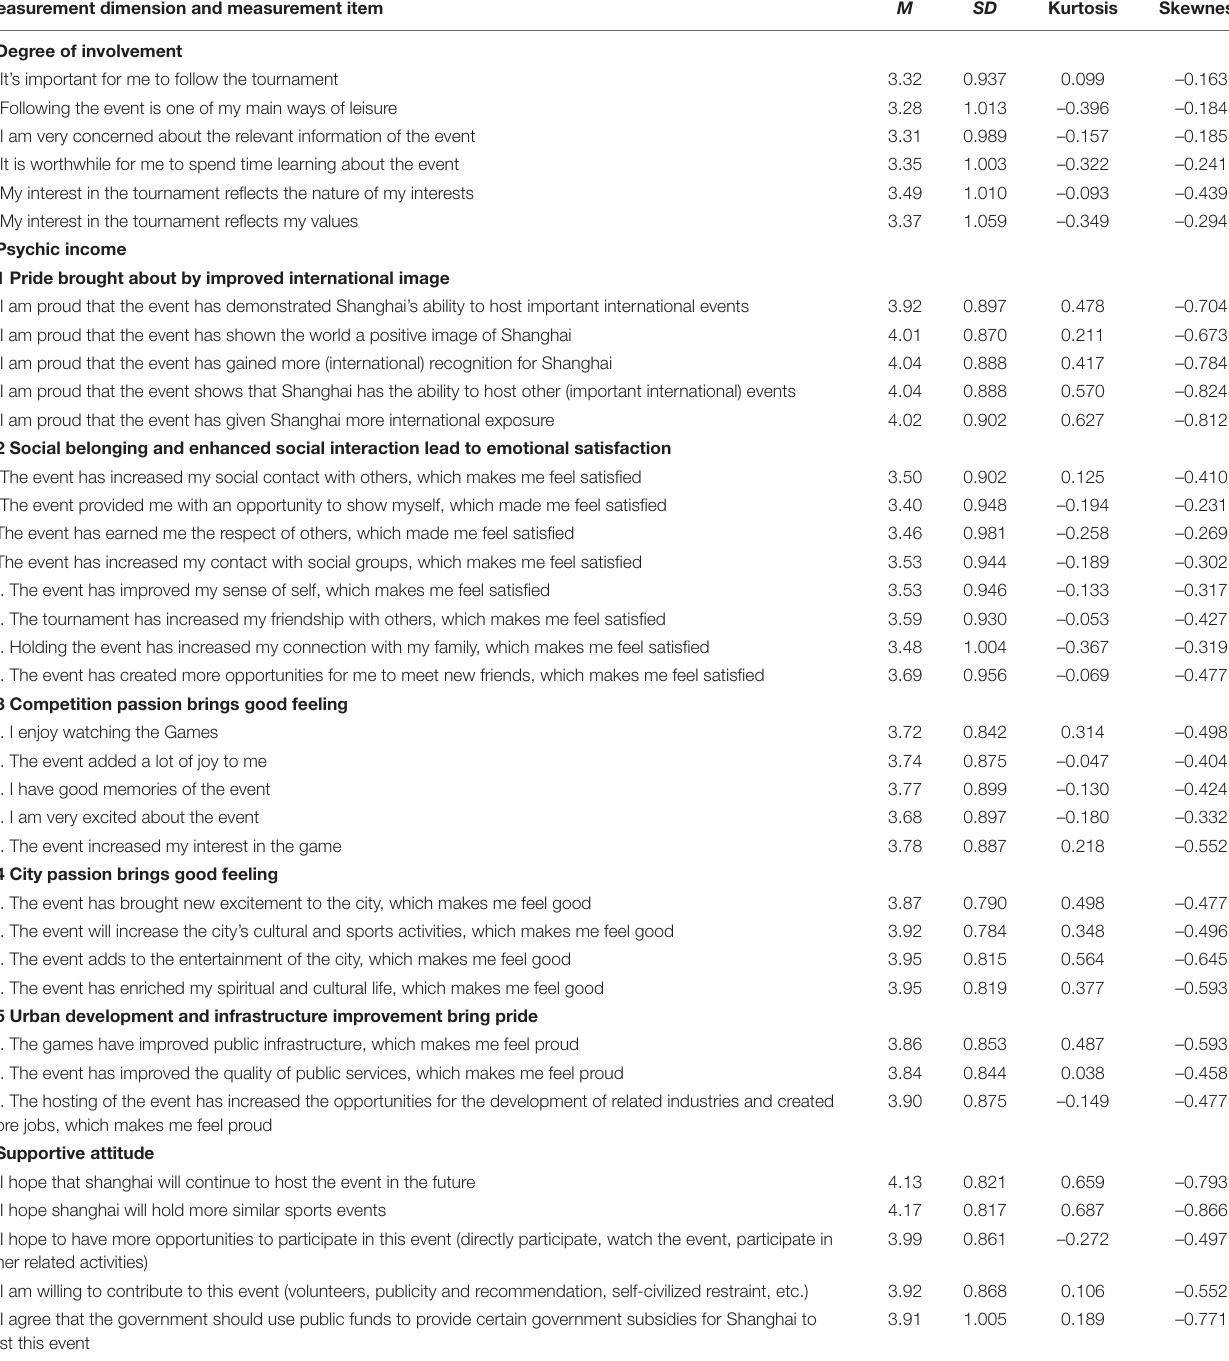
TABLE 2 | Descriptive statistics of sample data. Measurement dimension and measurement